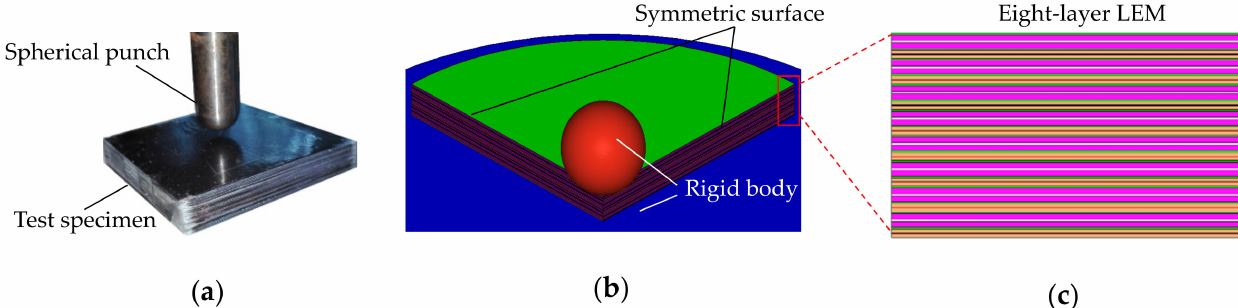
Figure 12. Local indentation test of multilayered LEMs under 6.3 mm spherical punch: ( a ) Experimental setup; ( b ) Finite element model of multilayered LEMs; ( c ) Enlarged view of layered structure of finite element